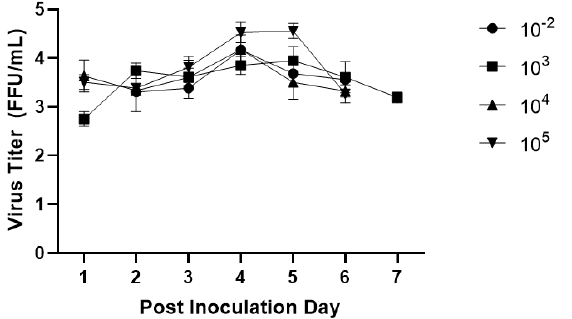
Figure 6. Mean daily virus shedding titer of Gn pigs with different doses of Arg HRV. Log(10) transformed data are presented. All dosage groups shed approximately the same level of the virus as determined by CCIF.